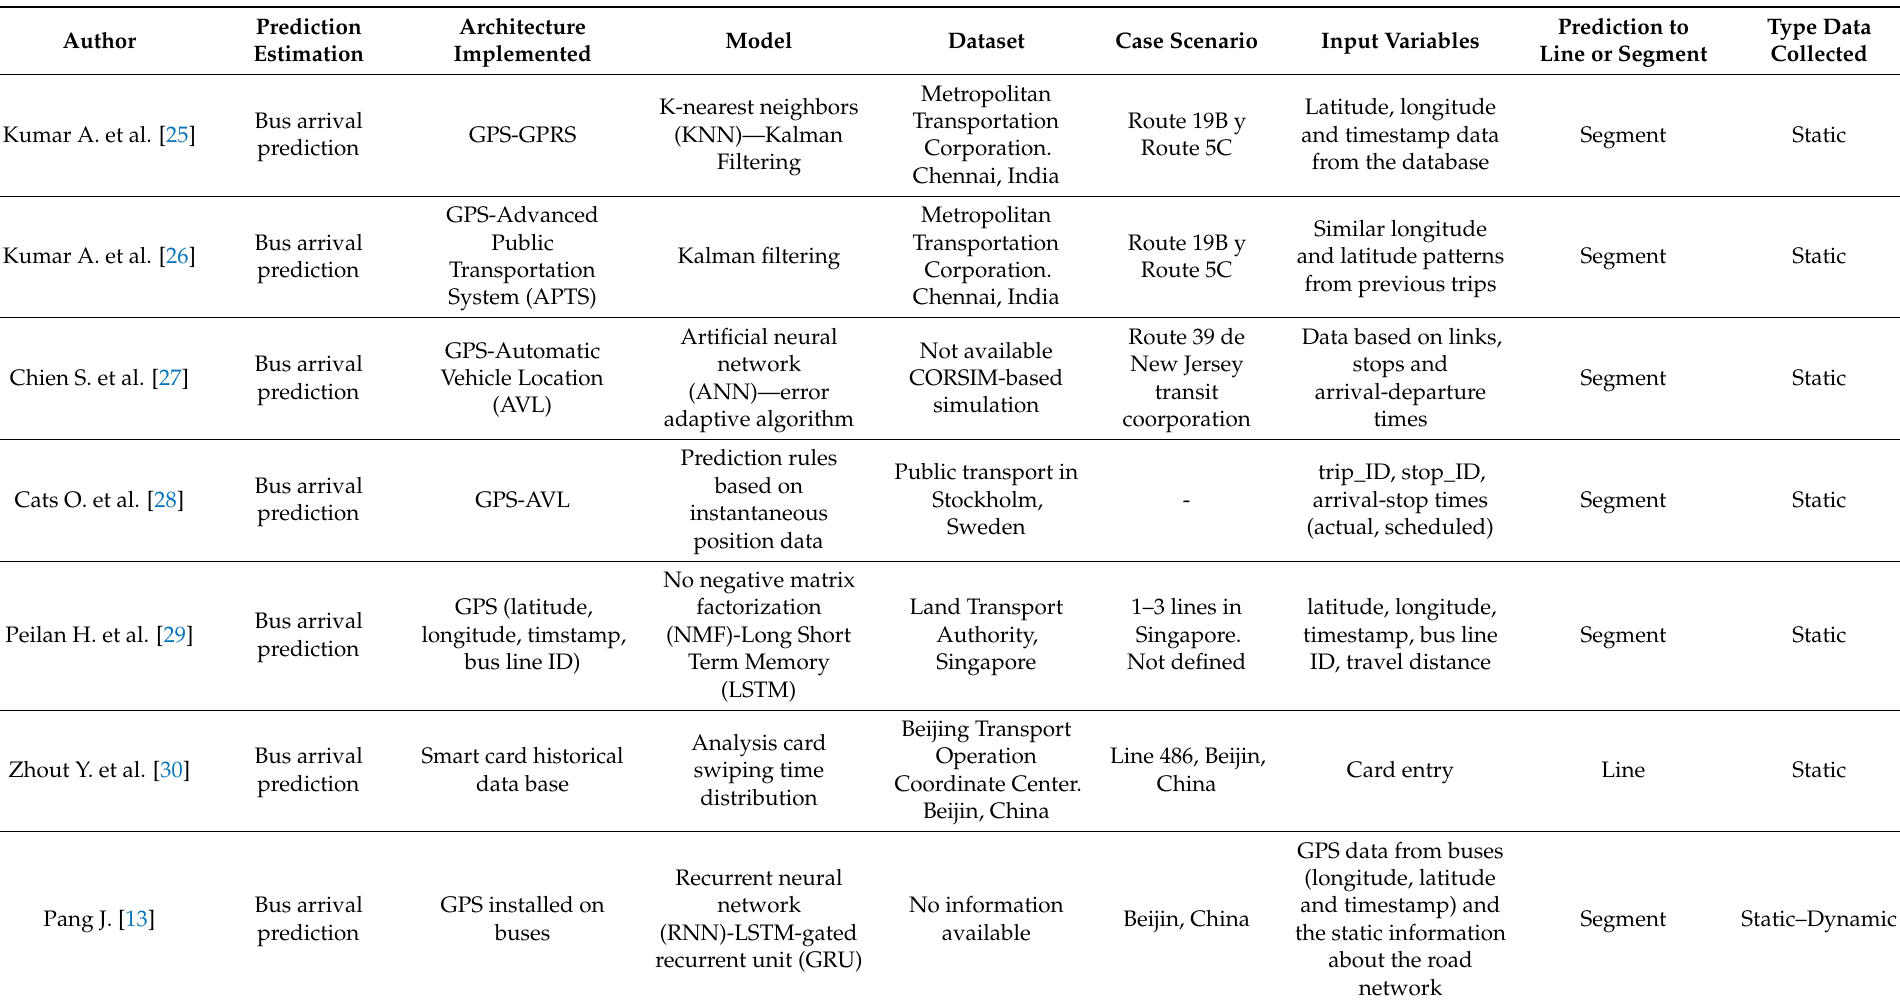
Table 1. Brief summary of state-of-the-art features and